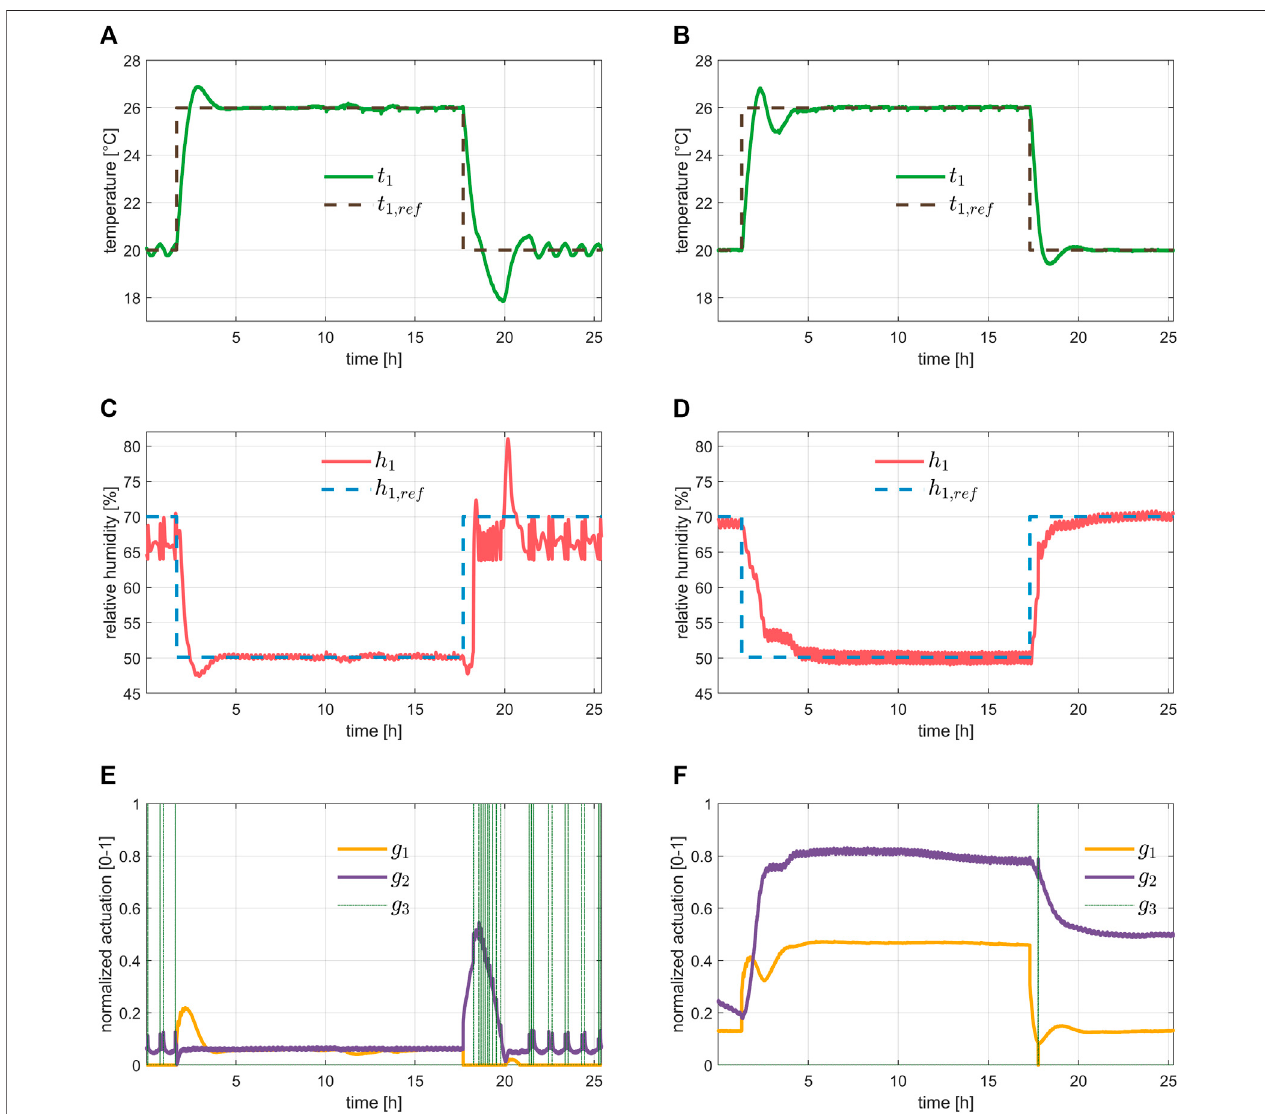
FIGURE8| Evaluationoftemperature and relative humidity controlfordifferentset-points, typical ofaday/nightcycle.Theleftcolumn showsthe resultsduring the fi rst day of the experiment described in Section 3.1 , while the second column shows the results during the last day . From top to bottom we have: the tracking performanceofthetemperatureinplots (A,B) ,thetrackingperformanceoftherelativehumidityinplots (C,D) ,andtheinputcommands,namelytheheater,dehumidi fi er, and humidi fi er in plots (E,F) .